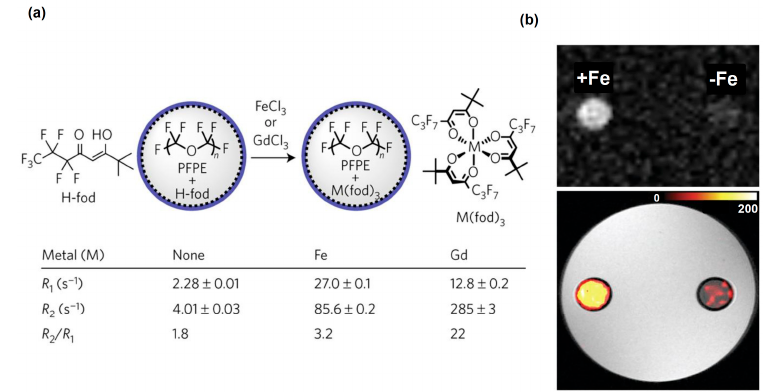
Figure 7. ( a ) Comparison of iron and gadolinium diketonates (H-fod) as 19 F relaxation agents for PFPE. The relaxometry results (9.4 T) are shown for PFPE emulsions (120 g l − 1 PFPE) containing H-fod (2.8 mM) 24 h after the addition of 0.7 mM metal ions. R 1 , spin–lattice relaxation rate (=1/T 1 ), and R 2 , spin–spin relaxation rate (=1/T 2 ), values are reported for the main PFPE peak at − 91.4 ppm. The results show that Fe 3+ is a more effective R 1 agent than Gd 3+ . ( b ) MRI of FETRIS nanoemulsion. Phantom comprised of two agarose-embedded NMR tubes containing FETRIS nanoemulsion (4.5 g·L − 1 19 F) with 0.5 mM Fe 3+ (R 1 /R 2 = 32.5/170 s − 1 ) and nanoemulsion without metal (R 1 /R 2 = 2.2/3.7 s − 1 ), denoted +Fe and − Fe, respectively. The top panel shows unthresholded 19 F images, and below, the 19 F image is thresholded, rendered in hot-iron pseudo-color (scale bar), and overlaid onto the greyscale 1 H image. The 19 F/ 1 H MRI data were acquired using a gradient echo (GRE) sequence. The images and caption are reprinted with permission from Kislukhin et al. [173].